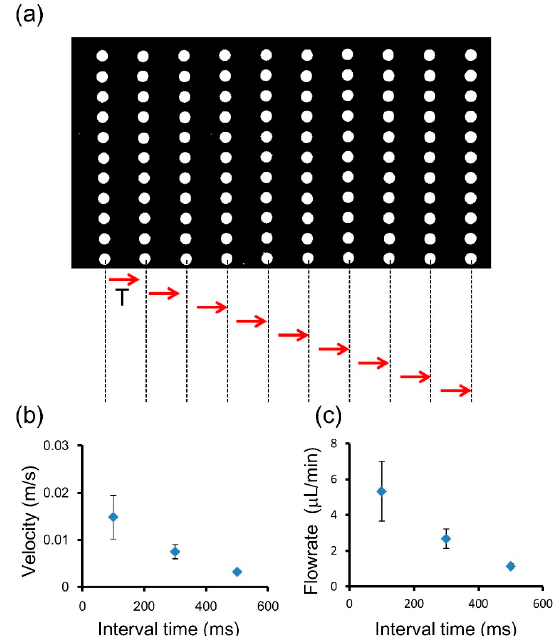
Figure 7. Relationship between valve operation time interval and on-chip flow rate. ( a ) The valve operation time interval indicates the time to start the action of the next line of valves; ( b ) The relation between the velocity and valve operation time interval; ( c ) The relation between the flow rate and valve operation time interval.